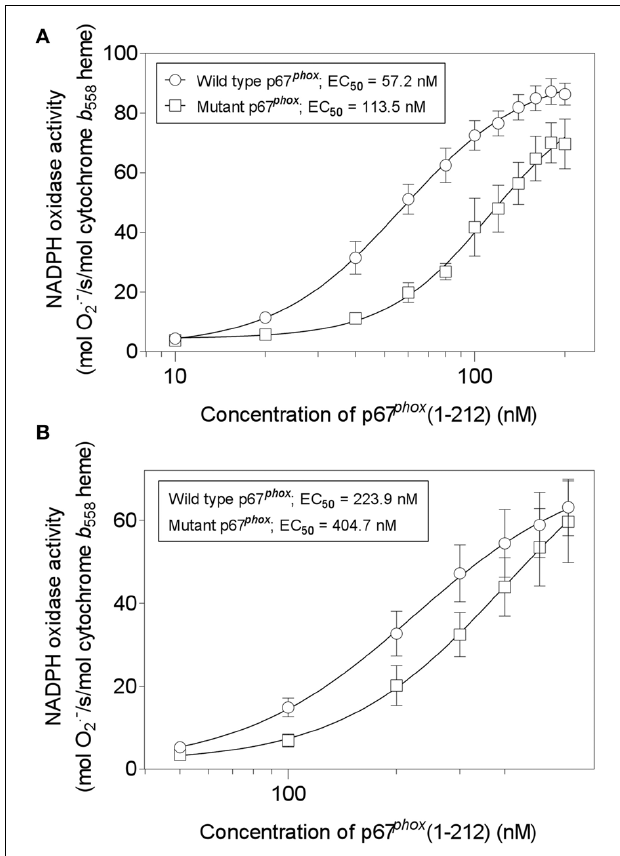
FIGURE 13 | Mutating all four cysteines in p67 phox (1–212) impairs its ability to support NADPH oxidase activation in a cell-free system. Wild-type p67 phox (1–212) and p67 phox in which 40 Cys, 45 Cys, 121 Cys, and 165 Cys were mutated to Ser, were assayed for the ability to support NADPH oxidase activation in a cell-free system. Two forms of assay were used. (A) The first (amphiphile- and p47 phox -dependent) consisted of macrophage membrane liposomes (5nM cytochrome b 558 heme), equal concentrations of p67 phox (wild-type or mutant), p47 phox , and Rac1 Q61L, varying from 10 to 200nM, and LiDS (120 μ M). Activation proceeded for 90s, followed by addition of 240 μ M NADPH, to initiate O ·− 2 production. (B) The second (amphiphile- and p47 phox -independent) consisted of macrophage membrane liposomes (5nM cytochrome b 558 heme) and equal concentrations of p67 phox (wild-type or mutant) and prenylated Rac1 Q61L, varying from 50 to 600nM. Activation proceeded for 5min, followed by addition of 240 μ M NADPH, to initiate O ·− 2